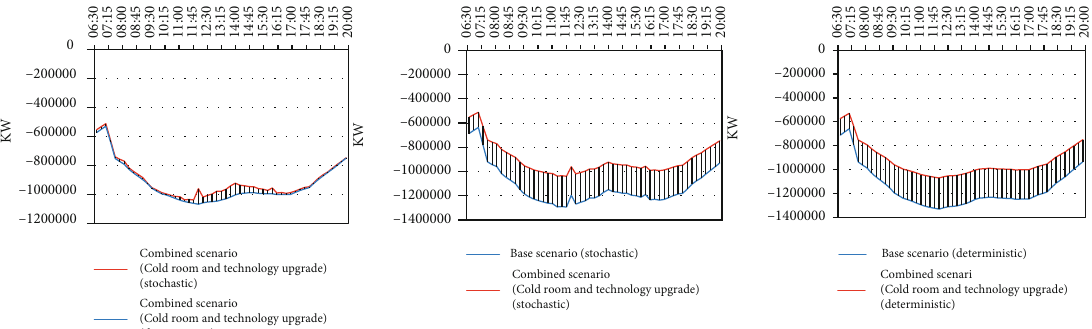
Figure 25: Di ff erent modes in the combined scenario (cold room and technology upgrade) (day).